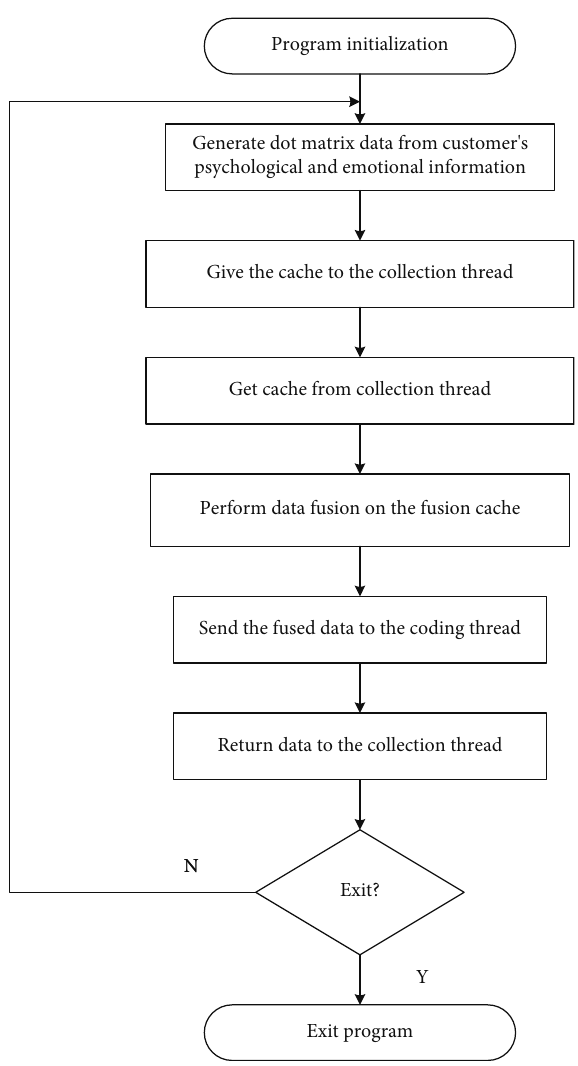
Figure 2: Flow chart of information fusion